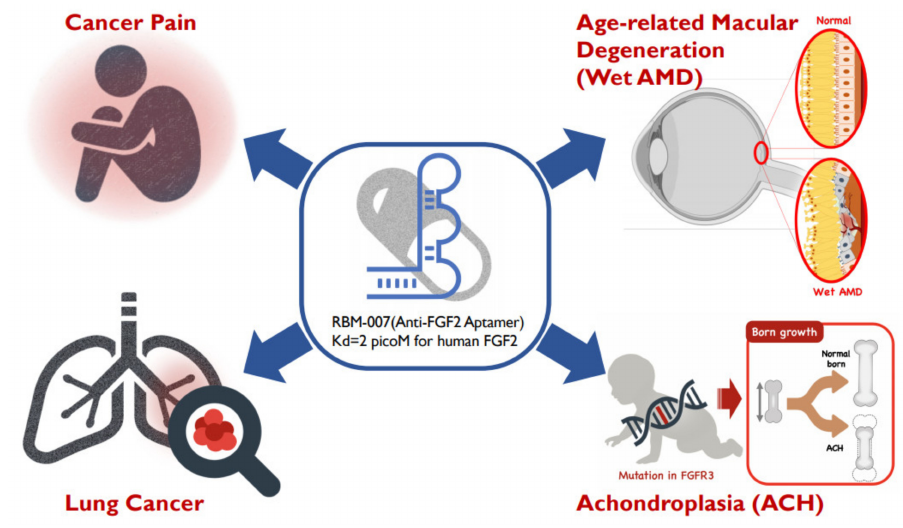
Figure 1. Diverse therapeutic applications of RBM-007 (anti-FGF2